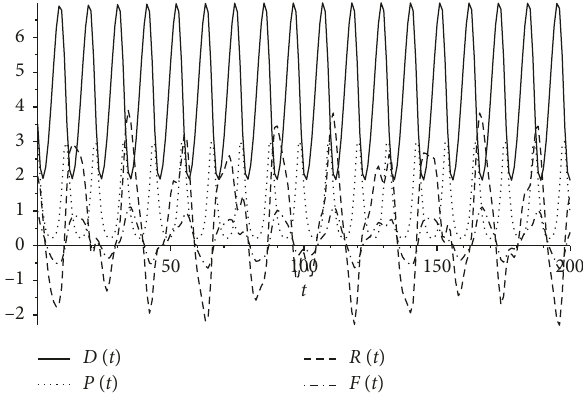
Figure 8: Numerical simulation diagram of system (2) when � 0 . 65 , τ � 7 . 71. τ 1 2